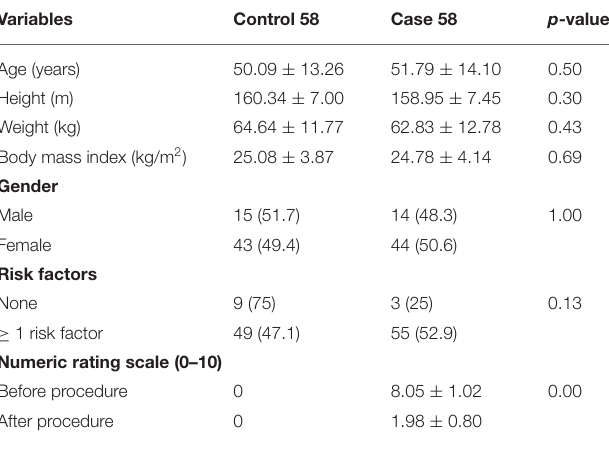
TABLE 1 | Demographics data of healthy and piriformis syndrome patients.